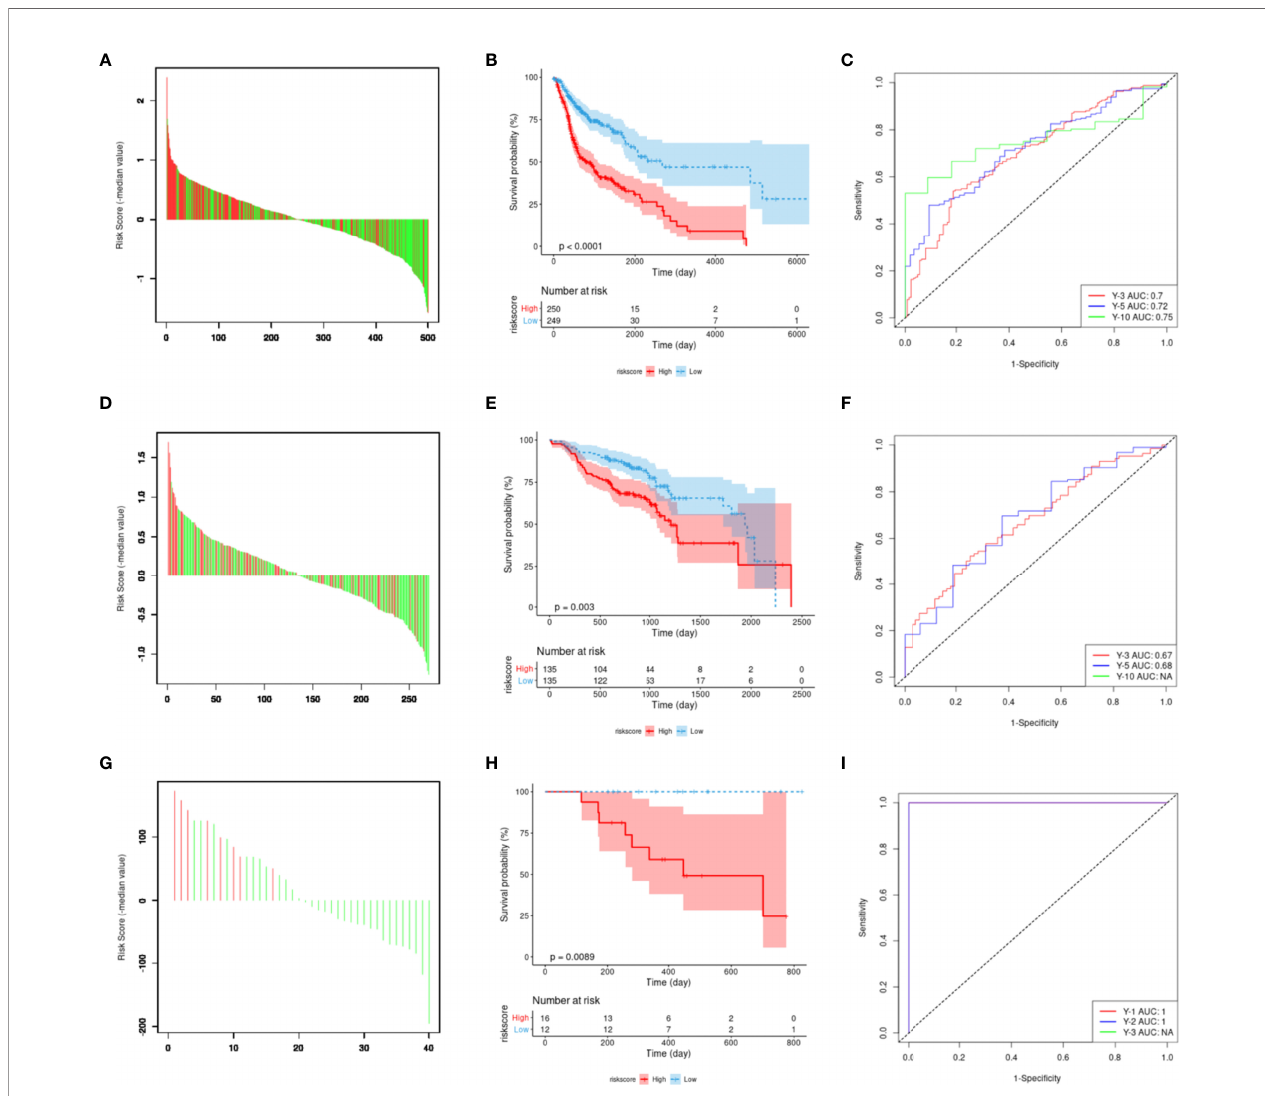
FIGURE 6 | Construction and evaluation of m6A regulator-related mRNA signature. (A) The risk score of the 12-gene model in the Cancer Genome Atlas dataset. Red represents the time to death, green represents survival status, and the ordinate represents the difference between risk and median scores. (B) Model risk score prognostic analysis of patient survival. (C) The receiver operating characteristic (ROC) curve is predicted by using the model. (D – F) External veri fi cation using the GSE65858 dataset. (G – I) Veri fi cation result for the ICGC ORCN-IN dataset.